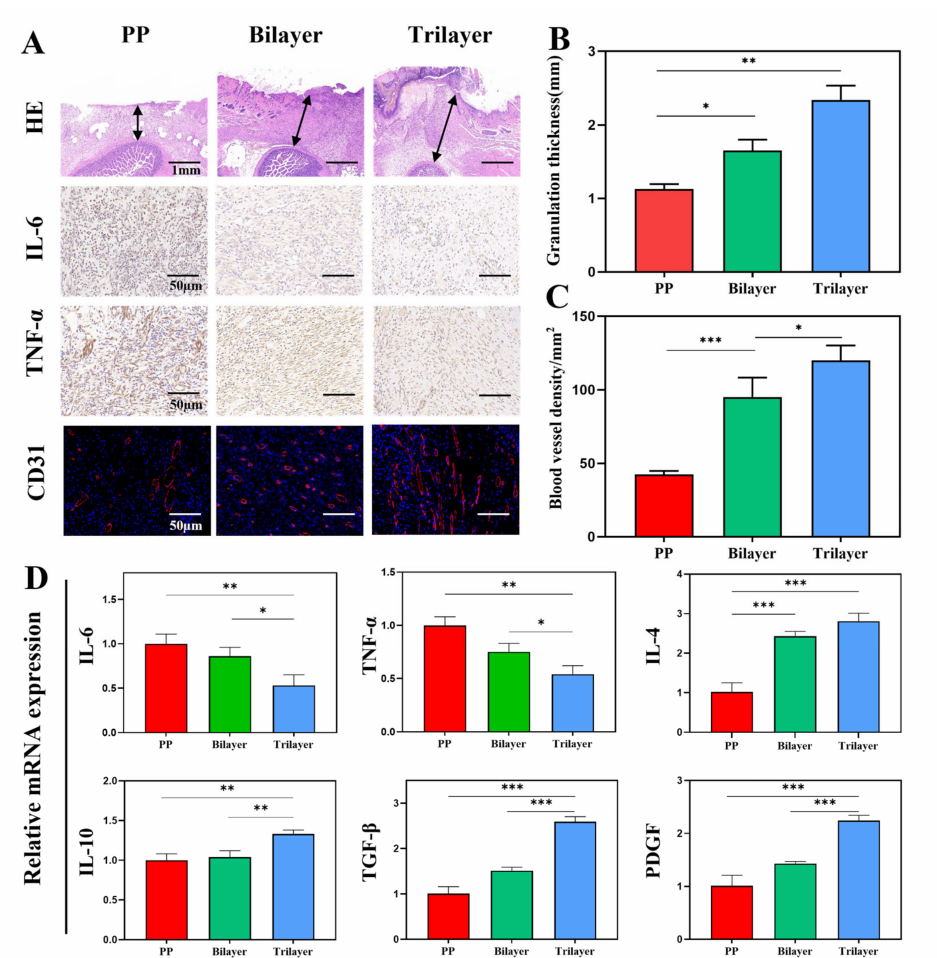
Figure 6. ( A ) H&E-stained, immunohistochemistry of IL-6, immunohistochemistry of TNF- α , and immunofluorescence of CD31. ( B ) Quantitative analysis of granulation tissue thickness. ( C ) Quantita- tive analysis of blood vessel density. ( D ) mRNA expression of IL-6, TNF- α , IL-4, IL-10, TGF- β , and PDGF. ( n = 3, mean ± SD, * p < 0.05, ** p < 0.01, *** p <